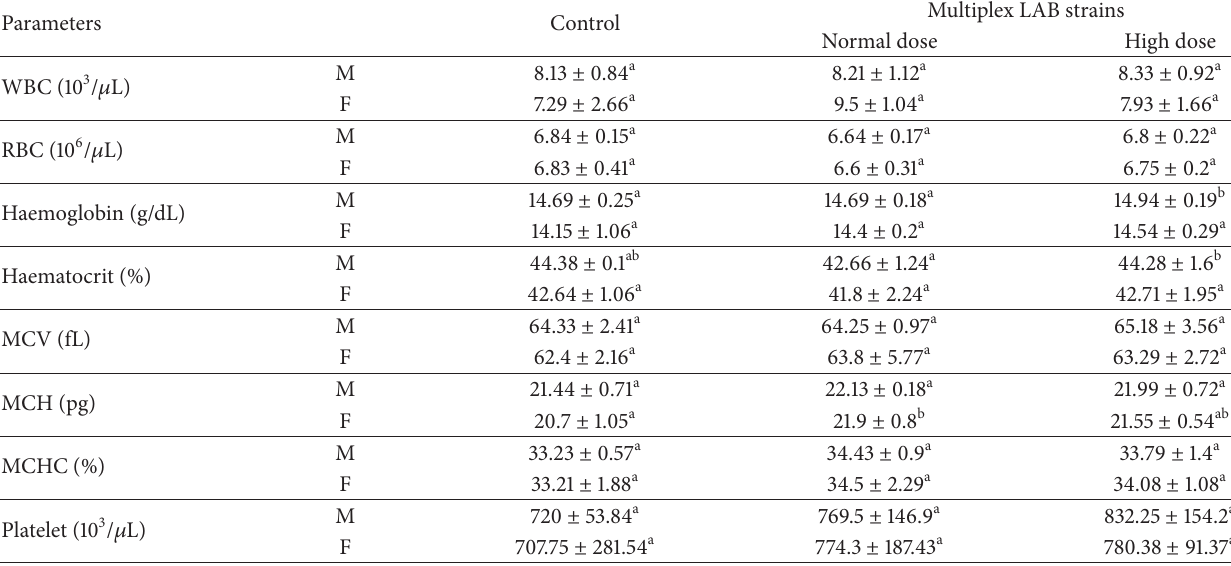
All values are represented as the mean ± S.D. of Wistar rat ( 𝑛 = 7-8/sex/dose). WBC: mean white blood cell; RBC: mean red blood cell; MCV: mean corpuscular volume; MCH: mean corpuscular hemoglobin; MCHC: mean corpuscular hemoglobin concentration; M: male; F: female. a,b 𝑃 < 0.05 compared with the control group by ANOVA followed by Dunnett’s test.